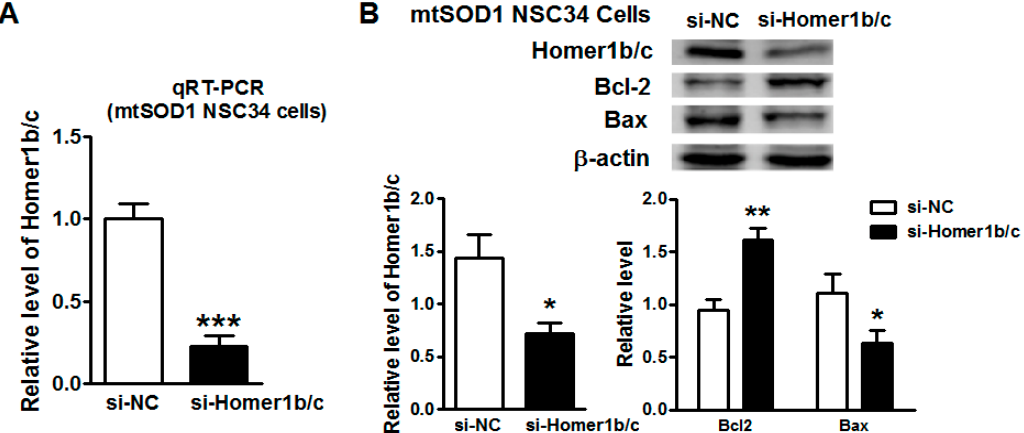
Figure 3. Knockdown of Homer1b/c protected mtSOD1 NSC34 cells from apoptosis. ( A ) The mRNA level of Homer1b/c was detected by qRT-PCR in mtSOD1 NSC34 cells after treatment with short interfering RNA (siRNA) negative control (NC) (si-NC)/siRNA Homer1b/c (si-Homer1b/c) for 72 h; ( B ) Western blot showed the expression of Homer1b/c protein and apoptosis-related proteins (Bcl-2 and Bax) in mtSOD1 NSC34 cells. * p < 0.05 vs. si-NC group, ** p < 0.01 vs. si-NC group, *** p < 0.001 vs. si-NC group. n = 3 independent batches of cells for each group.